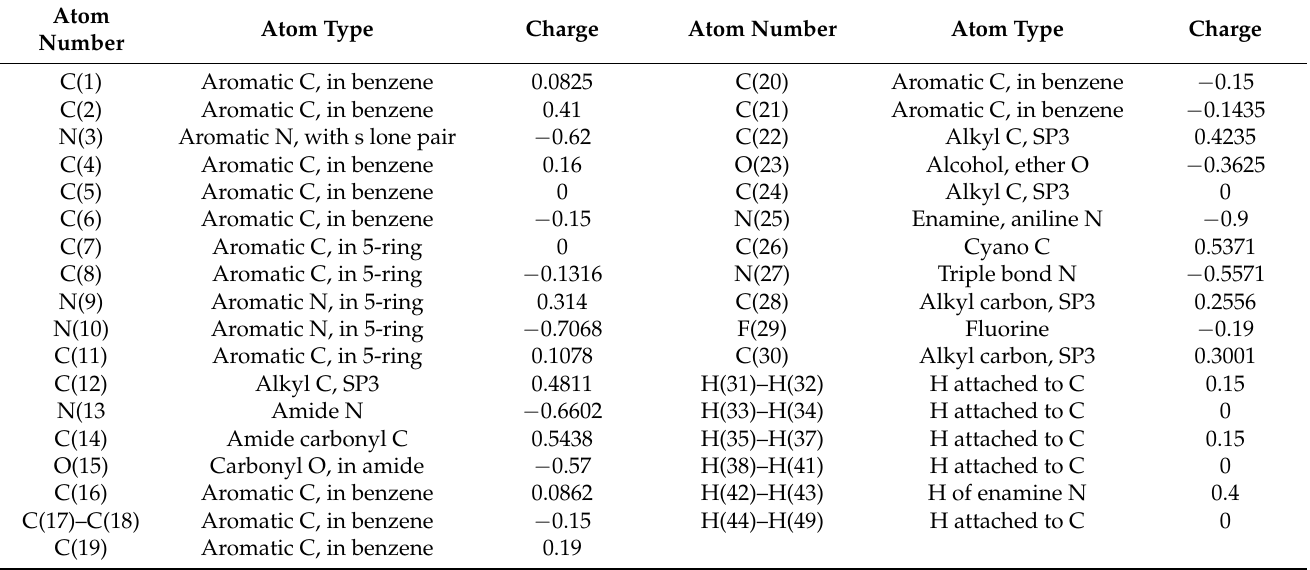
Figure 6. The scheme for the formation of the CTC between LOR and DDQ.